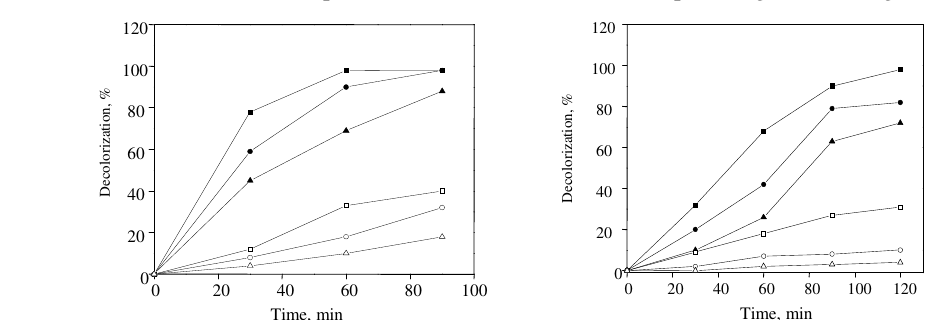
/UV.pH 4, 2 /UV pH 10, 2